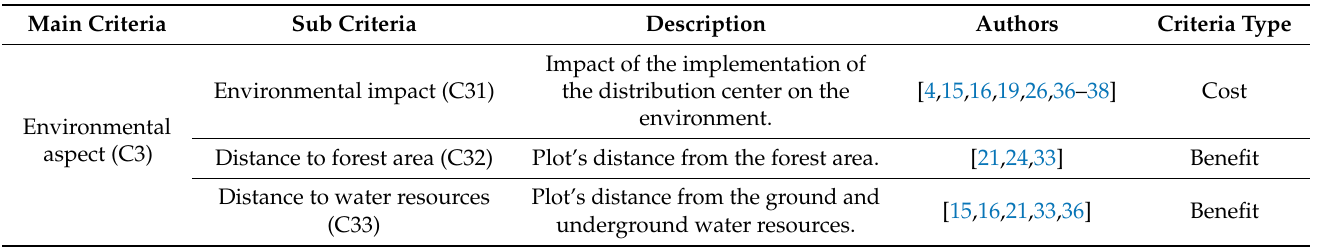
Table 3. Environmental aspect: Criteria for selection of distribution center